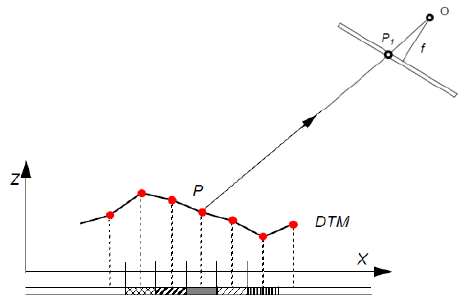
Figure1, getting gray value to rectified